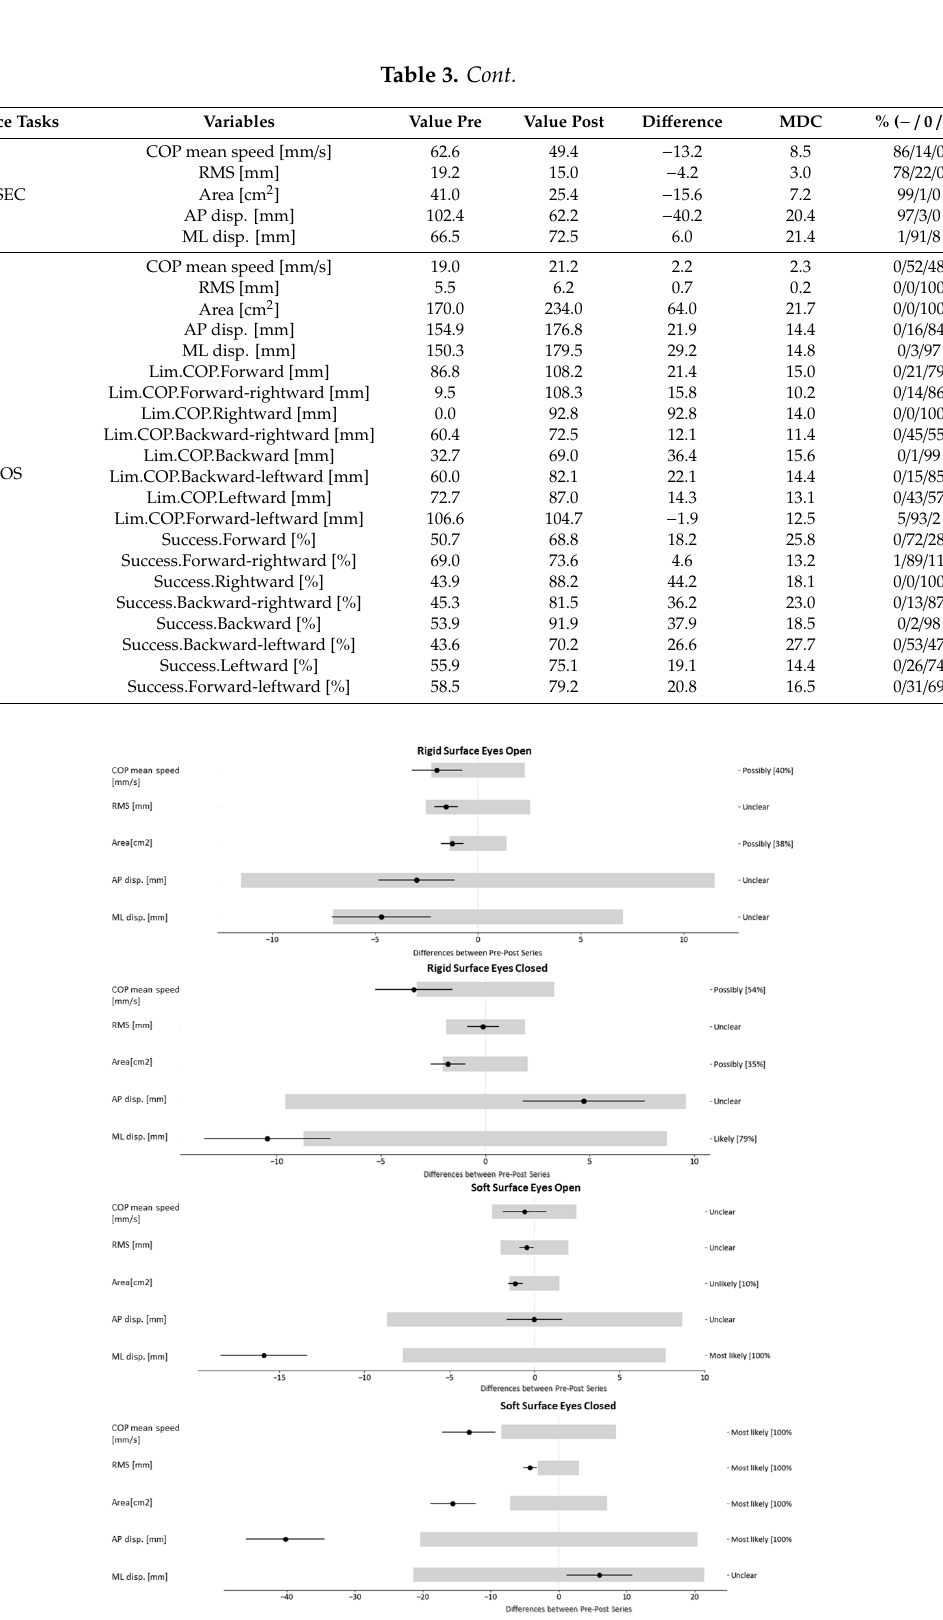
Figure 2. Patient level analysis. Romberg Test. Minimal detectable change (MDC): light grey bars; Differences: thin Black bars.